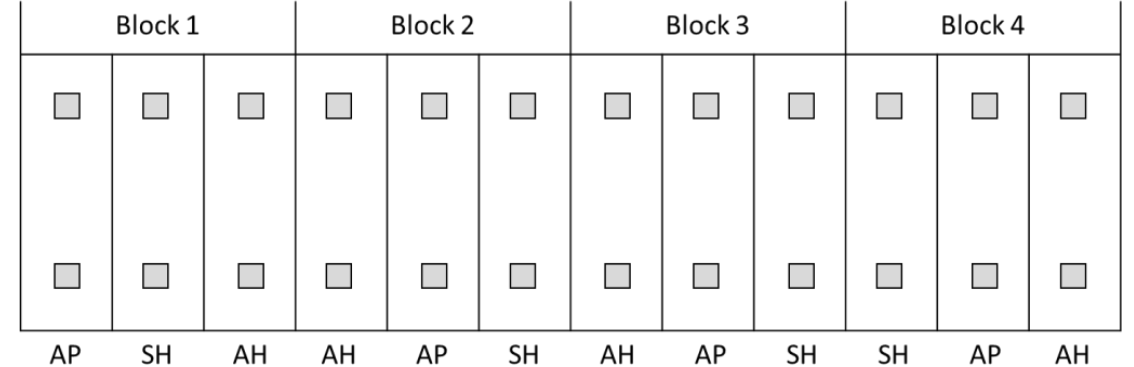
Figure 1. The experimental design with four blocks in a linear arrangement with 12 plots with three randomly located treatments AP: autumn ploughing, AH: autumn harrowing, and SH: spring harrowing for termination of the IWG crop. Small grey squares indicate the approximate position of the squared frames used for sampling. Illustration not according to scale. Table 1. Overviewofthedatesforthemanagement, treatmentsandsamplinginthepilotproject. Abbreviations: IWG = intermediate wheatgrass, Bulk dens = soil bulk density. Superscripts A = plant count and B = biomass